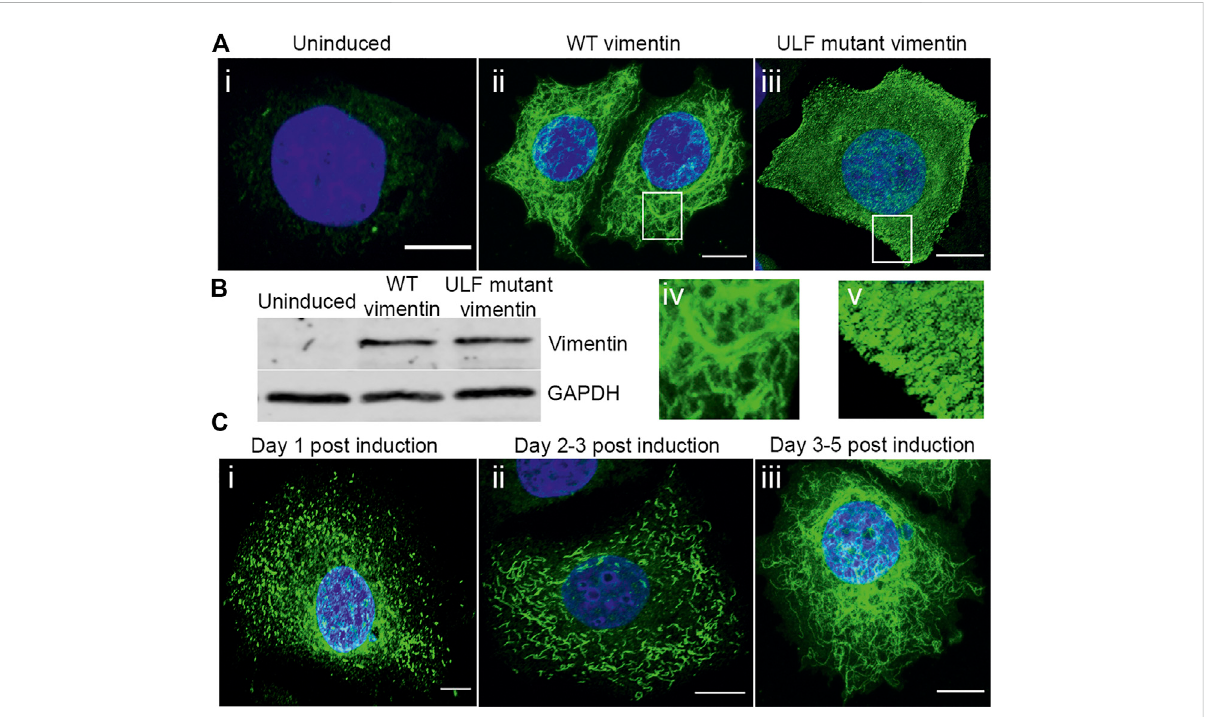
FIGURE 1 Expression and assembly stages of vimentin in inducible MCF7. (A) Immuno fl uorescence images of vimentin expression in (A) (i) uninduced MCF7 and (ii) cumate-induced MCF7 cells expressing WT vimentin and (iii) ULF mutant vimentin. Magni fi ed images of WT vimentin or ULF mutant expressing cells are shown in (iv) and (v) respectively. (B) Western blot showing the expression levels of vimentin in uninduced MCF7 cells, WT vimentin in MCF7 cells following induction and ULF mutant vimentin in MCF7 cells, run along with an internal control, GAPDH. (C) Immuno fl uorescenceimagesofvimentinincumate-inducedMCF7cellsexpressingWTvimentin. C(i)andC(ii)showthevimentinonday1(C-i)and day 2 (C-ii) post cumate induction as particles and squiggles respectively, indicating the assembly stages of vimentin. c-iii is observed on day 5